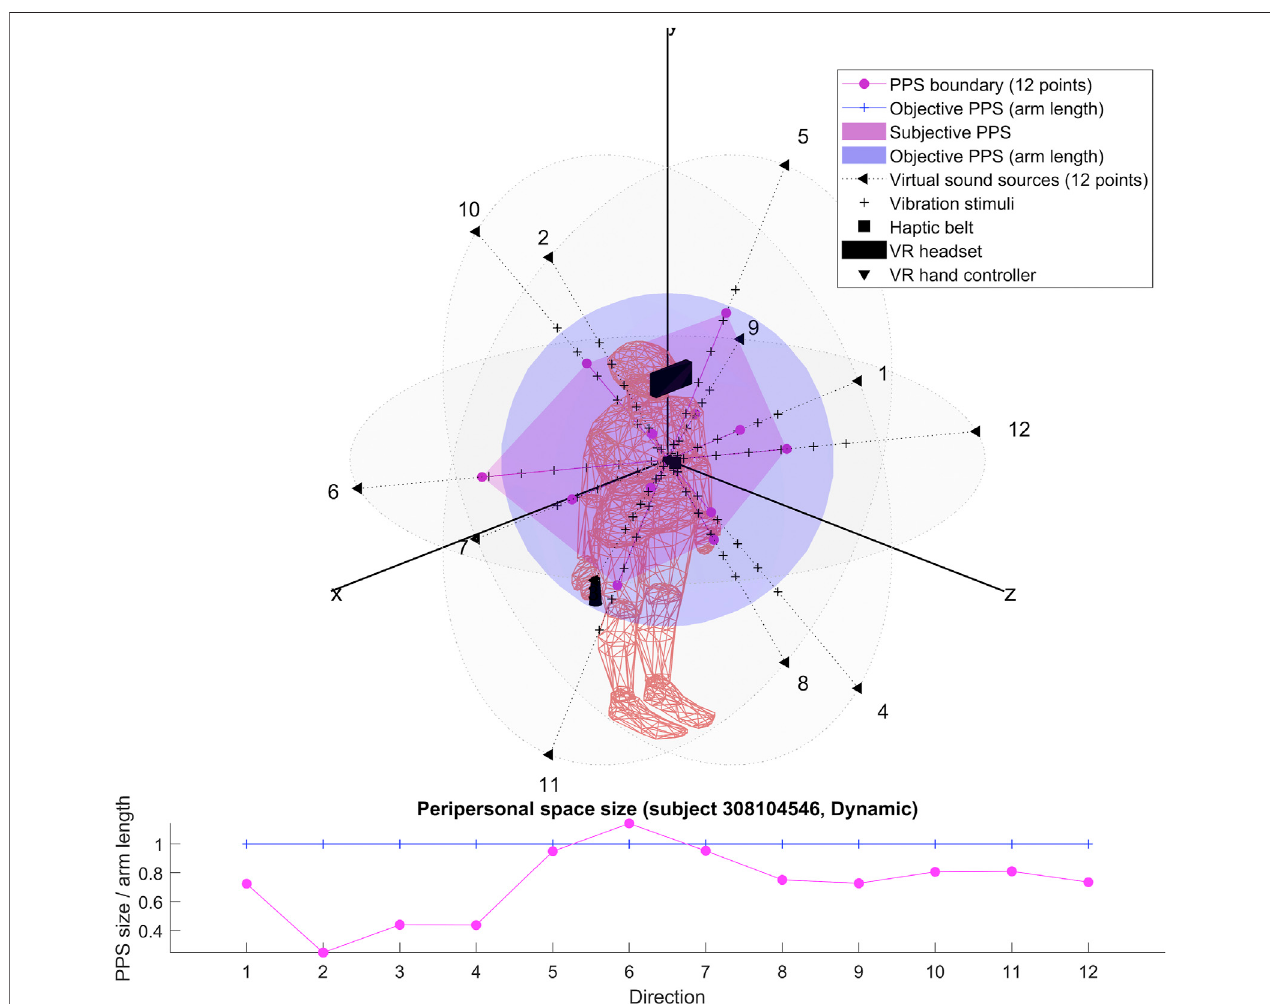
FIGURE 9 | PPS 3D representation for subject 308104546 dynamic